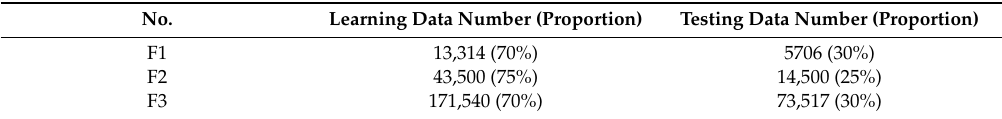
Table 2. Number and proportion of data sets in the DNM.